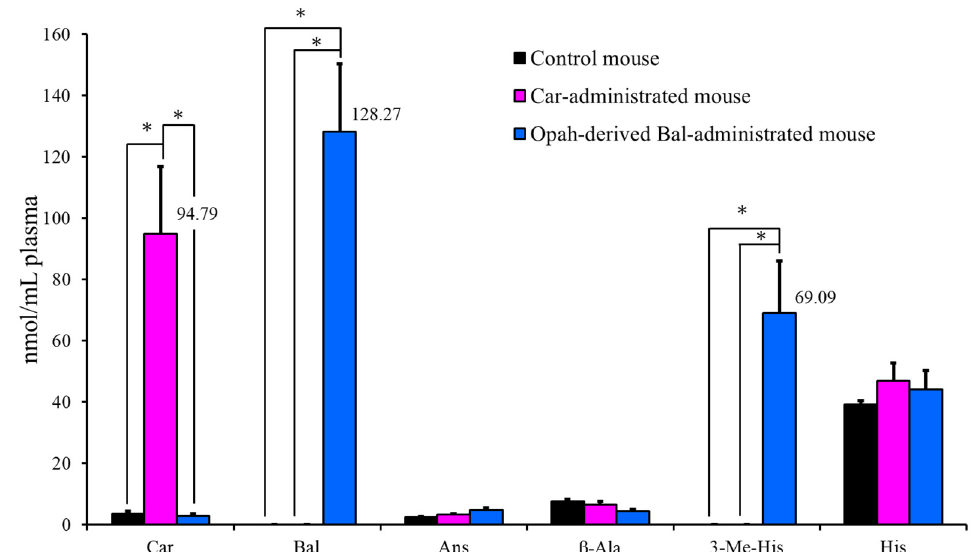
Figure 6. The concentration of imidazole peptides and constituents in mouse plasma 1 h after the administration of water (control), carnosine (Car-administrated mouse), and opah-derived balenine (opah-derived Bal-administrated mouse) at 200 mg/kg body weight. The concentrations of carnosine (Car), balenine (Bal), anserine (Ans), β -alanine ( β -Ala), 3-methylhistidine (3-Me-His), and histidine (His) are presented as means ± SD ( n = 3). Asterisks indicate significant differences (* p < 0.01).